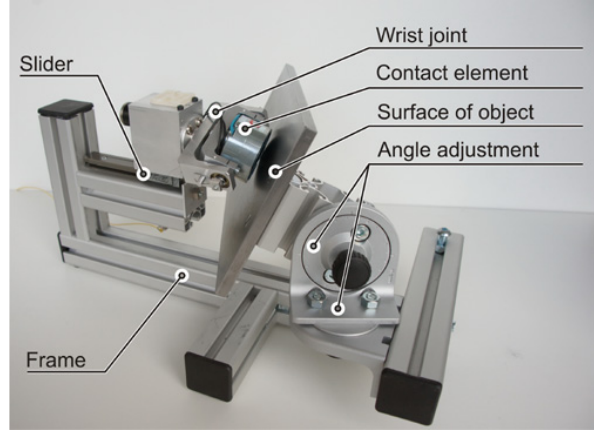
Figure 6. Wrist joint prototype.